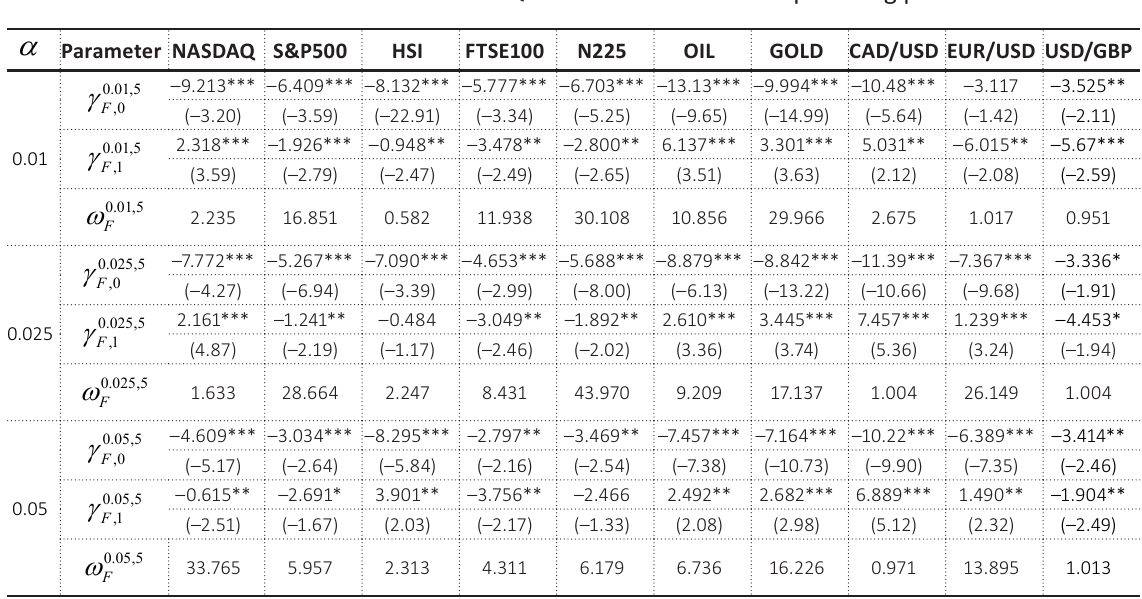
Table A4. Parameter estimation of F-MIDAS-Q model under the 10-step holding